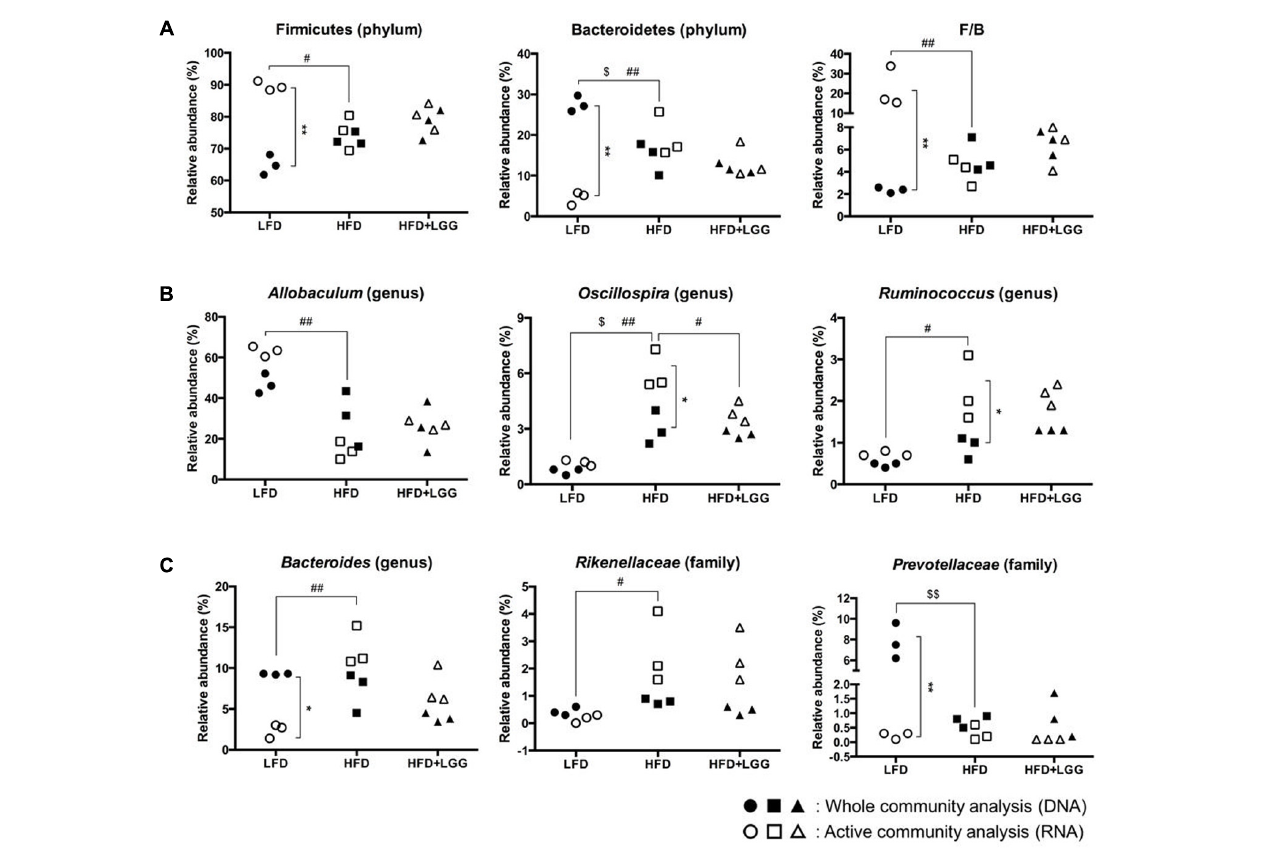
FIGURE 5 | Fecal microbiota of LFD, HFD, and HFD+LGG groups. Black colored circle, rectangle, and triangle illustrate results of DNA analysis while empty symbols illustrate results of RNA analysis. (A) Firmicutes, Bacteroidetes, and Firmicutes over Bacteroidetes ratio (F/B); (B) major sub-groups of Firmicutes ; (C) major sub-groups of Bacteroidetes . Significance level was calculated using ANOVA and Bonferroni’s multiple comparisons test and ∗ shows significant difference between DNA and RNA analysis, $ shows significant difference of LFD and HFD+LGG compared to HFD according to DNA analysis and # shows significant difference of LFD and HFD+LGG compared to HFD according to RNA analysis. The level of significance is expressed by the number of symbols (one = < 0.05, two = < 0.01, three = <